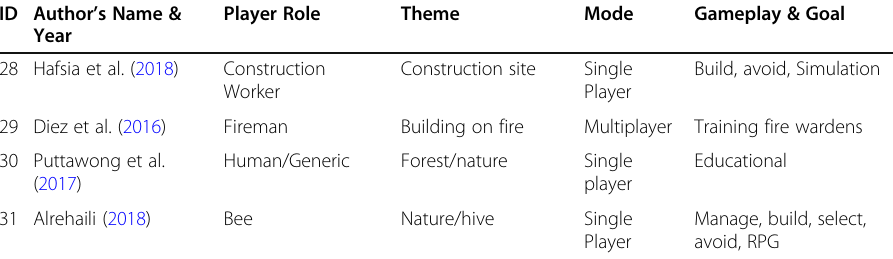
Table 8 Gaming characteristics of EVRGs